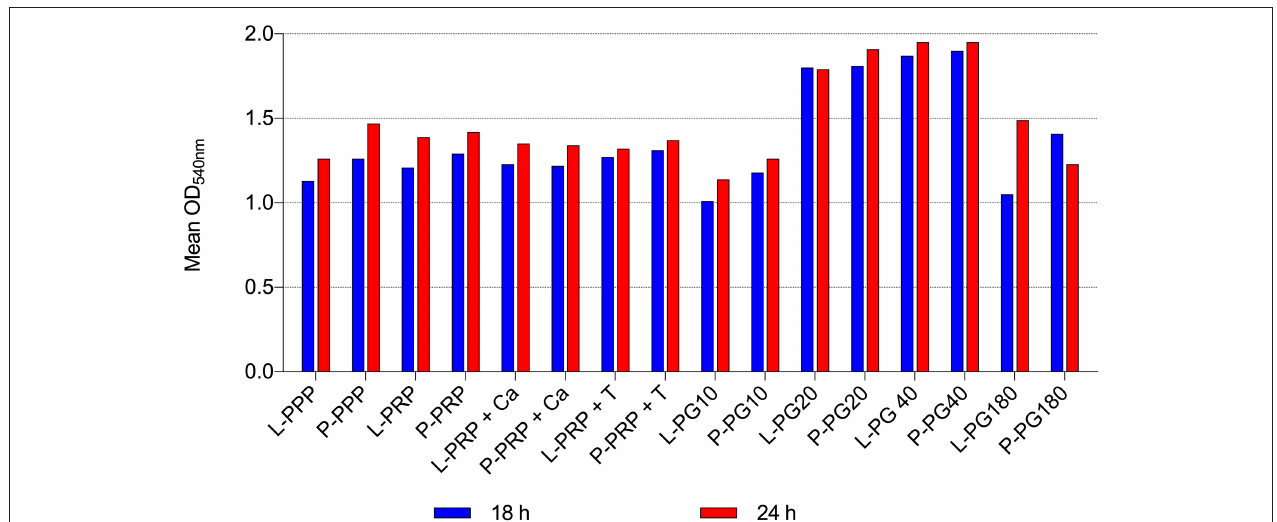
FIGURE 5 | Mean OD 540nm values of Gram-positive bacteria observed after 18 and 24h of incubation in presence of different non-transfusional hemo-components. L-PPP, leukocyte platelet-poor plasma; P-PPP, pure platelet-poor plasma; L-PRP, leukocyte platelet-rich plasma; P-PRP, pure platelet-rich plasma; L-PRP + Ca, leukocyte platelet-rich plasma with calcium gluconate; P-PRP + Ca, pure platelet-rich plasma with calcium gluconate; L-PRP + T, leukocyte platelet-rich plasma with thrombin-rich solution; P-PRP + T, pure platelet-rich plasma with thrombin-rich solution; L-PG10, leukocyte platelet gel 10 µ l; P-PG10, pure platelet gel 10 µ l; L-PG20, leukocyte platelet gel 20 µ l; P-PG20, pure platelet gel 20 µ l; L-PG40, leukocyte platelet gel 40 µ l; P-PG40, pure platelet gel 40 µ l; L-PG180, leukocyte platelet gel 180 µ l; P-PG180, pure platelet gel 180 µ l.